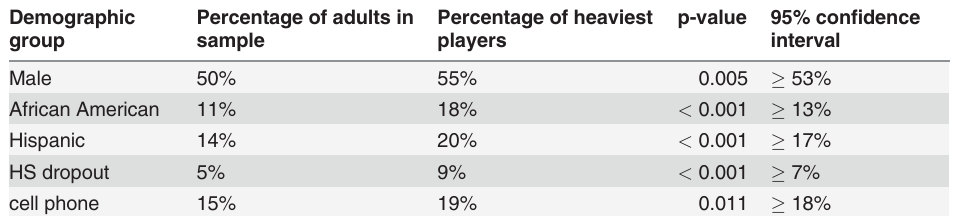
Table 2. Representation of demographic groups in the top 20% of lottery players. P-values and con fi dence intervals are calculated using a binomial distribution based on the percentage of adults in the sample.